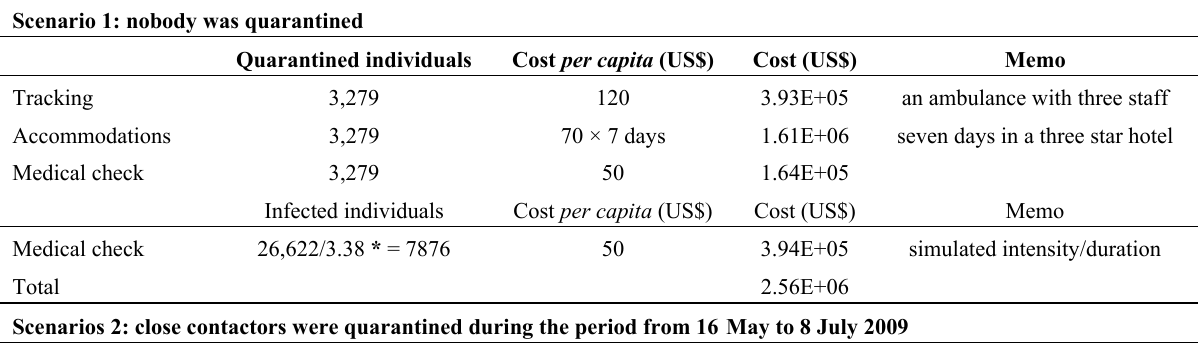
Table 1. Cost effectiveness analysis for quarantine against the 2009 H1N1 pandemic in